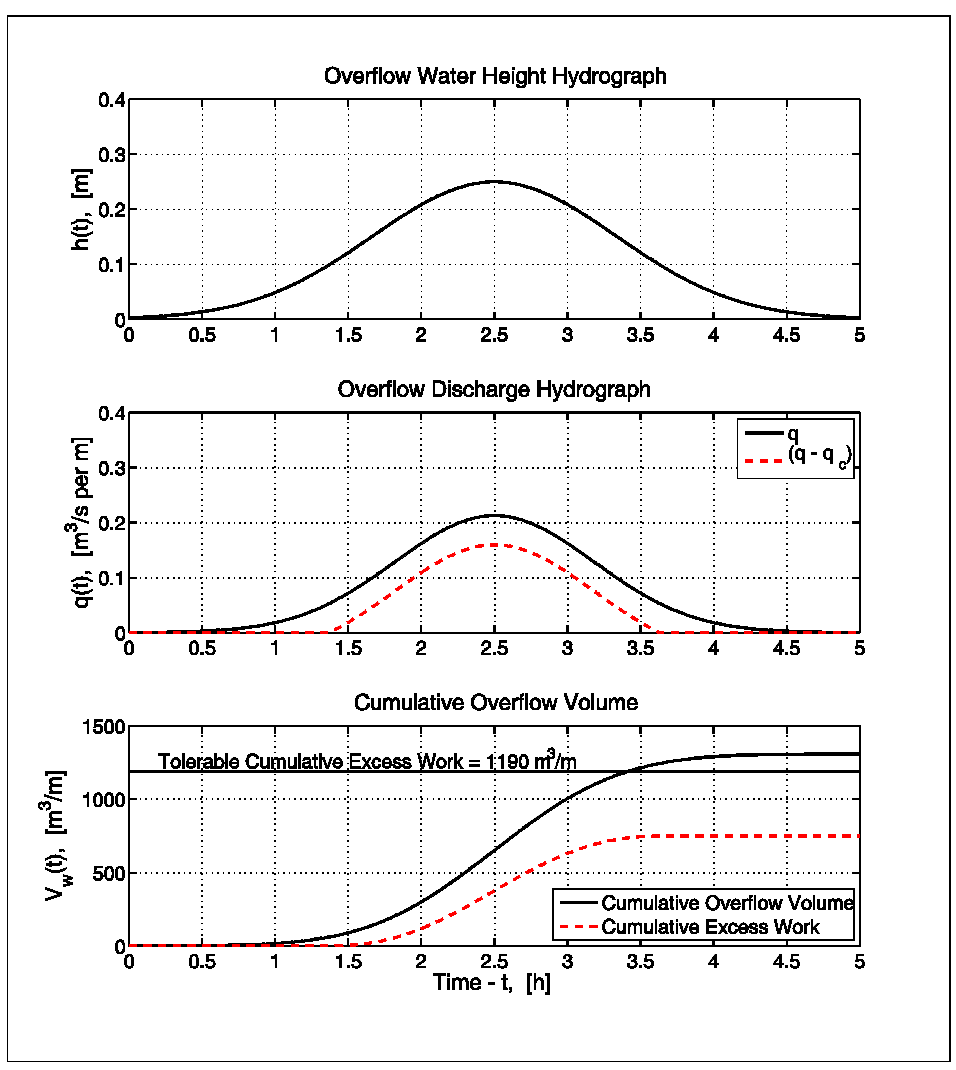
Figure 7. Example of cumulative excess work estimate for grass with u c = 2.8